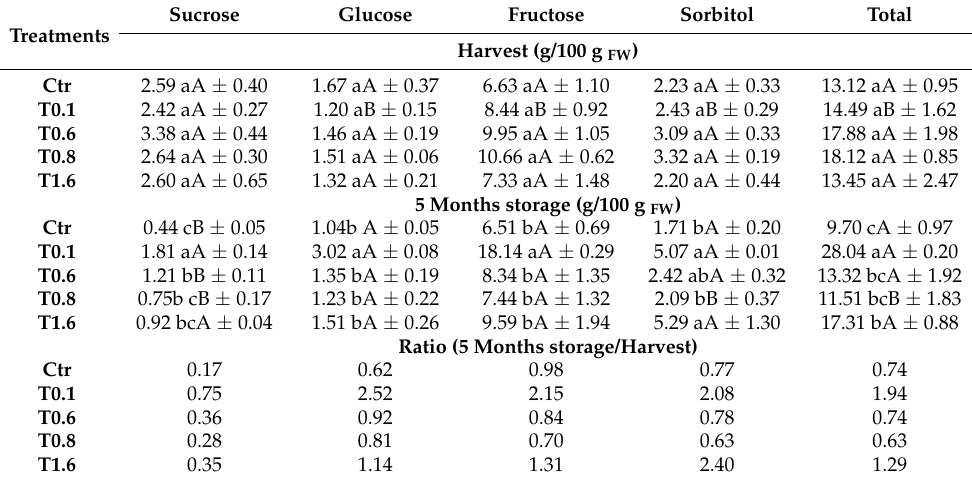
Table 2. Average ± S.E. of sugar content (sucrose, glucose, fructose, sorbitol and total) from Rocha pear from September (harvest) and March (5 months of storage). Treatments Ctr, T0.1, T0.6, T0.8 and T1.6 correspond to the control and initial foliar spraying with 0.1 and 0.6 kg · ha − 1 Ca(NO 3 ) 2 and 0.8 and 1.6 kg · ha − 1 CaCl 2 , respectively. Letters a, b and c represent significant differences among treatments for each date, while A and B represent significant differences between harvest and 5 month storage for each treatment.